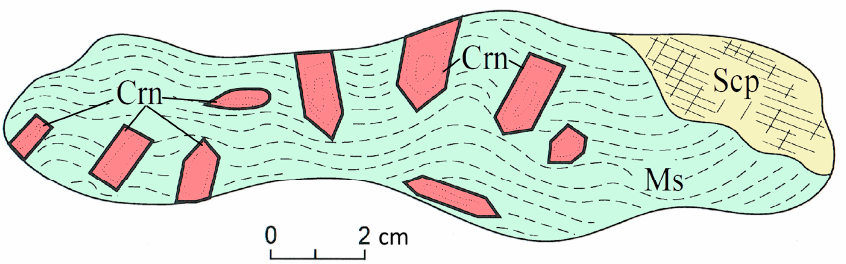
Figure 6. The sketch of a fragment of a ruby-bearing rock showing the apparent random orientation of ruby crystals. Crn—ruby crystals, Ms—muscovite (dashed lines), of ruby crystals. Crn—ruby crystals, Ms—muscovite (dashed lines), Scp—scapolite.